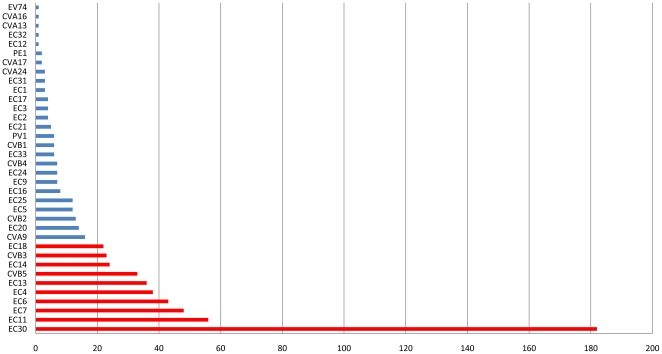
Distribution of Enterovirus serotypes isolated in Marseille, 1985–2005.The 10 most common serotypes isolated between 1985 and 2005 in Marseille account for 77.1% of all cases. Shown in red: (in decreasing order) E30, E11, E7, E6, E4, E13, CVB5, E14, CVB3 and E18. The top 5 most frequently encountered serotypes alone account for 56.7%.